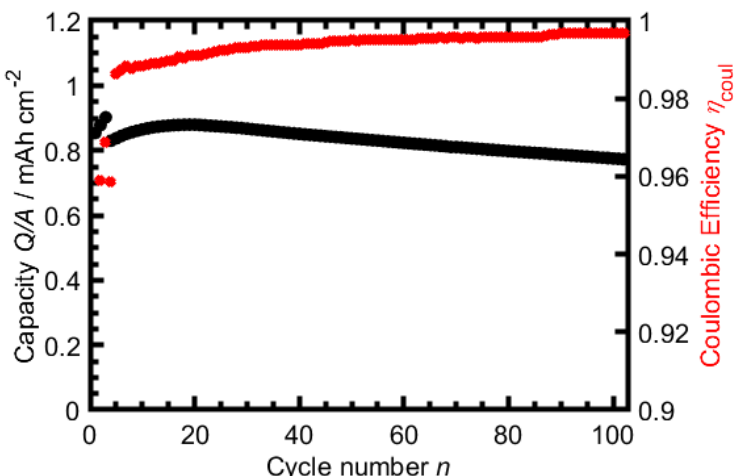
Figure 6. Cycling performance of a graphite/NCM cell with 1 M LiPF 6 in TBAC:EC:EMC:DEC (60:15:5:20 wt) electrolyte at T = 25 ◦ C. The cell was charged and discharged at C−rate C